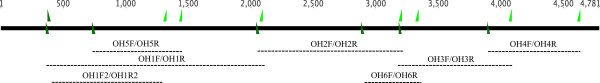
Primer sites (Forward: dark green arrow, Reverse: light green arrows) along the msp1 gene. Amplified fragments with corresponding primer pairs (Additional file 1) are represented by dashed lines.